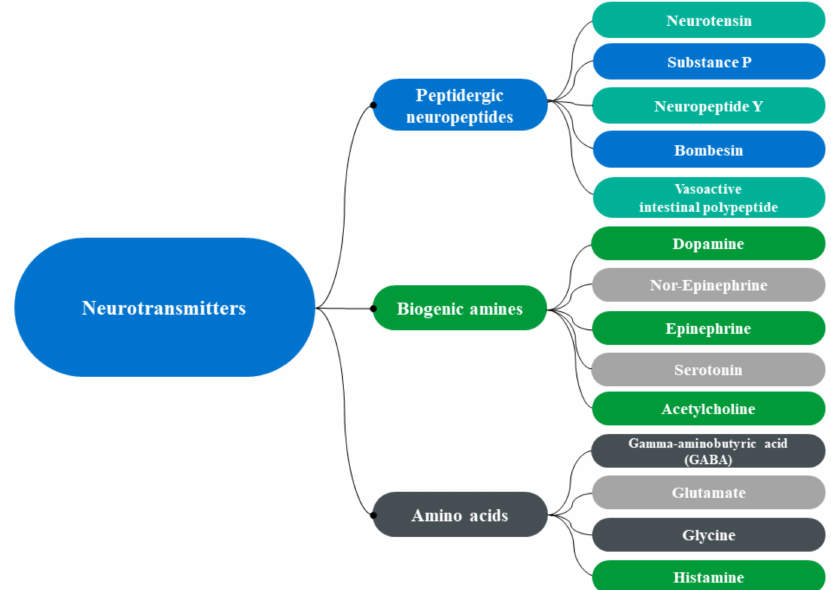
Figure 1. Chemical classification of